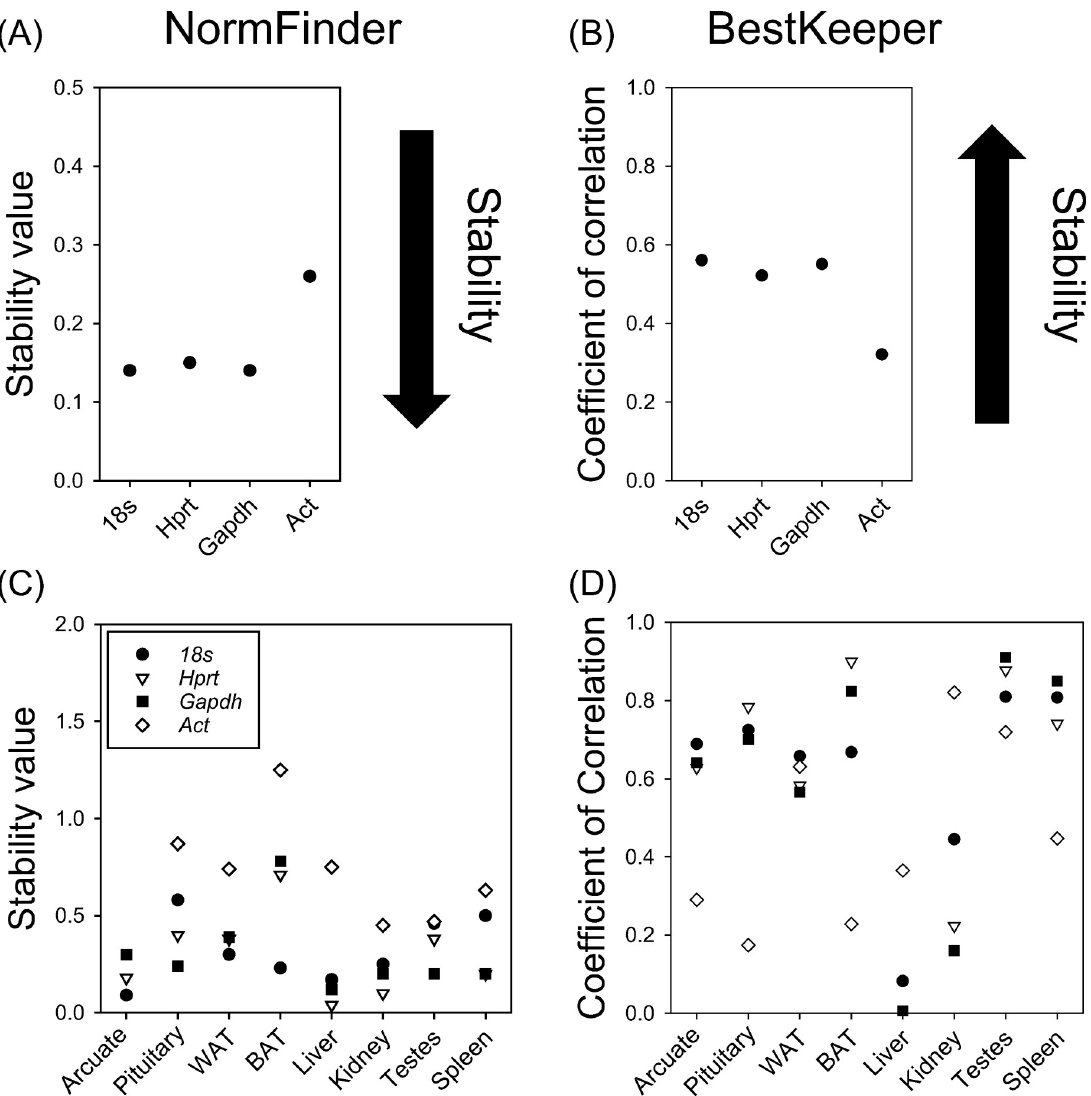
Fig 5. Stability of 18s, Hprt, Gapdh and Act expression across multiple hamster tissues. Stability in reference transcript levels across multiple tissues using NormFinder (A). 18s, Hprt, and Gapdh show high stability while Act has lower stability across all tissues. Note that lower NormFinder values represent higher stability. Stability in reference transcripts across tissued based on Bestkeeper (B). 18s, Hprt, and Gapdh show high stability while ACT has lower stability. Note that higher BestKeeper values represent higher stability. Tissue specific effects on photoperiod stability of 18s, Hprt, Gapdh and Act using Normfinder (C). Stability of 18s, Hprt, and Gapdh across photoperiods remains high in all tissues while Act shows lower stability. Tissue specific stability of 18s, Hprt, Gapdh and Act across photoperiods using Bestkeeper (D). Stability of 18s, Hprt, and Gapdh remains high in most tissues, Act has highest stability in the pituitary gland.